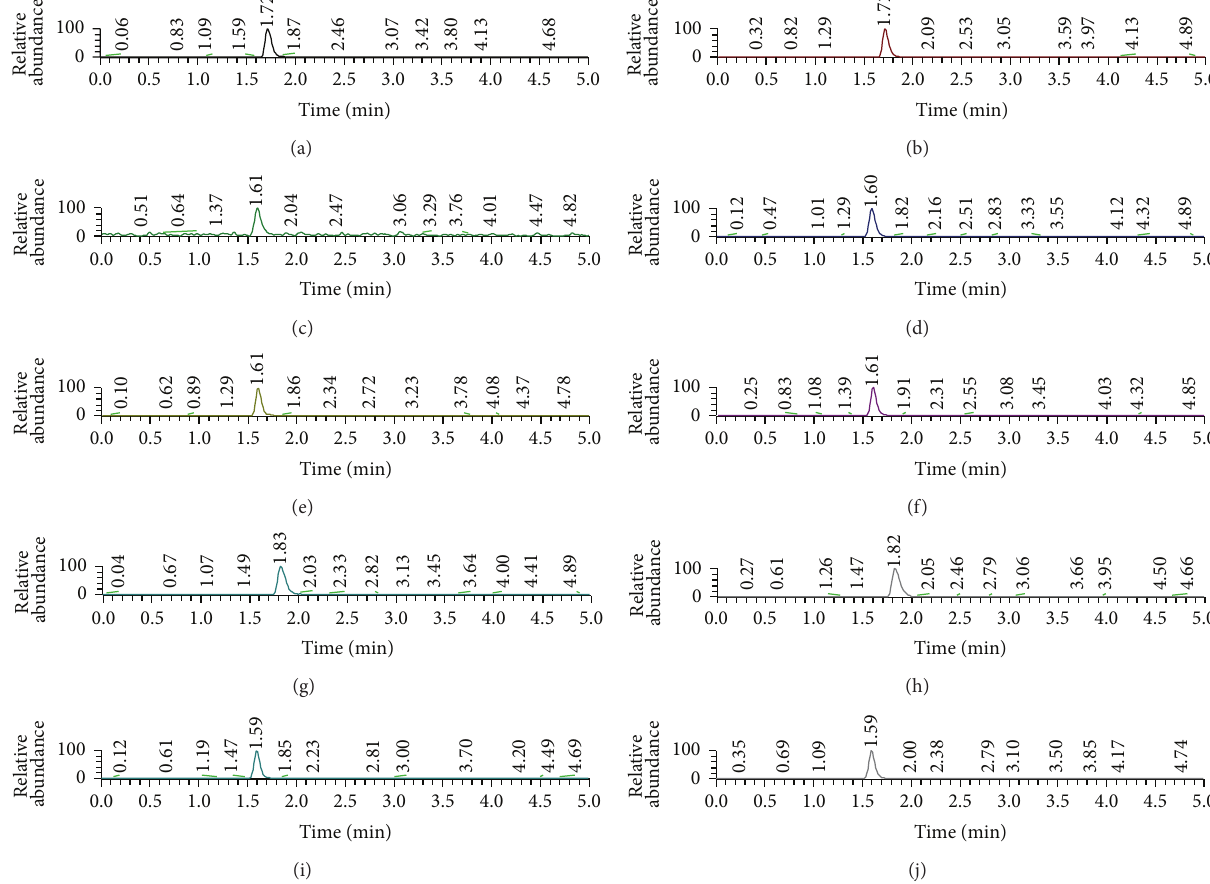
Figure 5: The LC-MS/MS chromatograms of neurotransmitters, (a) serotonin, (b) serotonin-D 4 , (c) norepinephrine, (d) norepinephrine-D 6 , (e) epinephrine, (f) epinephrine-D 3 , (g) glutamate, (h) glutamate-D 5 , (i) GABA, and (j) GABA-D 6 .